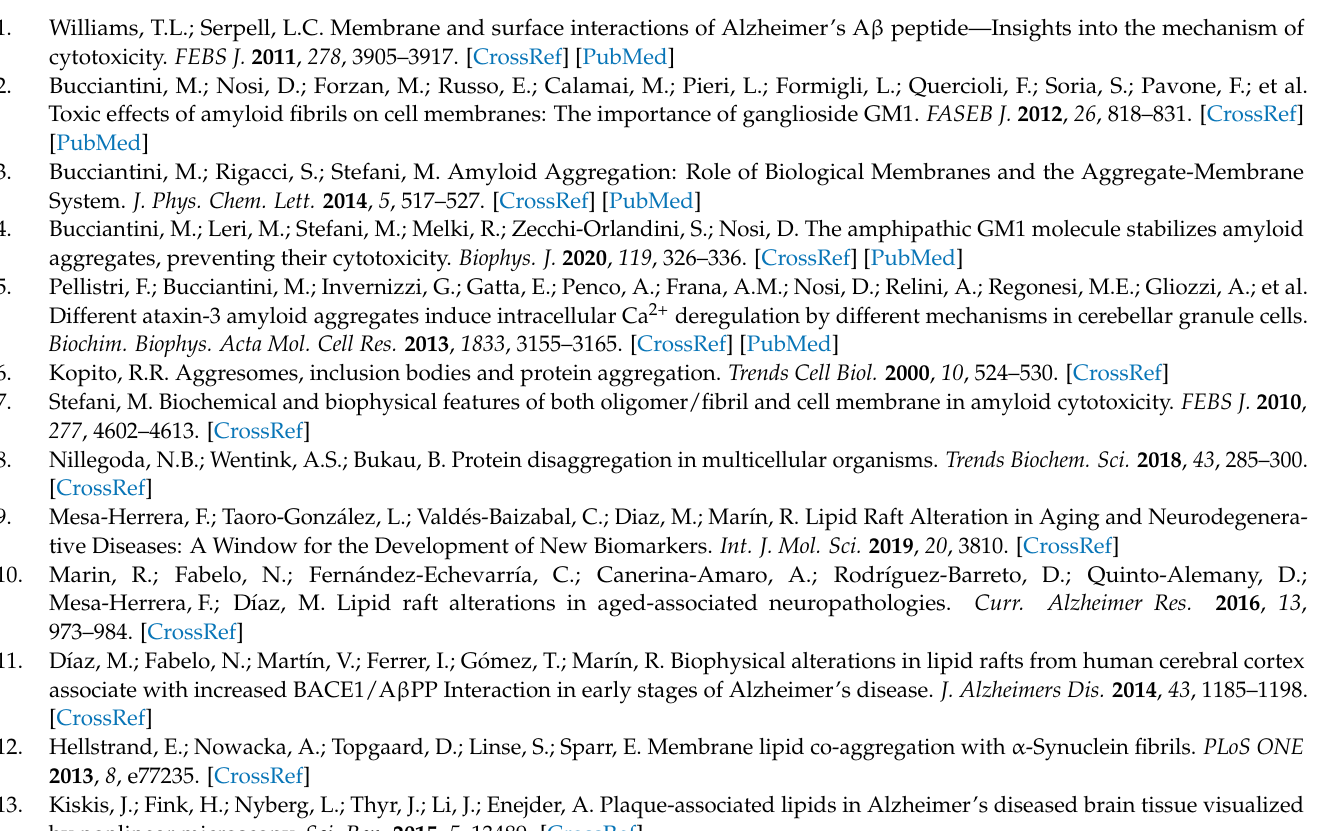
Figure S2: FRET interactions occurring between GM1 and A β -42 amyloid. Figure S3: FRET interac- tions occurring between PolySia and A β -42 amyloid. Table S1: Quantitative analysis of colocalization between A β 42 immunofluorescence and GM1 fluorescent